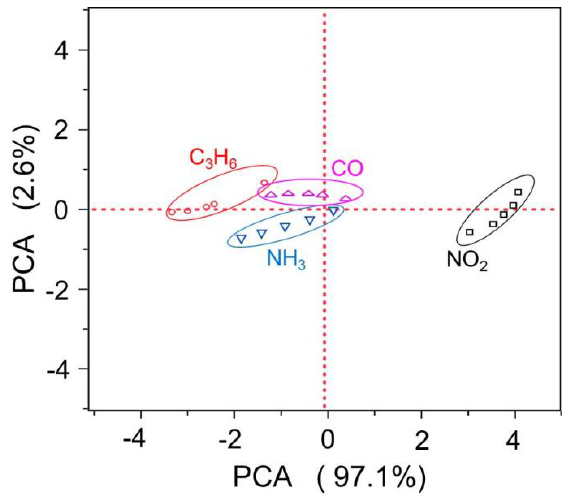
Figure 7. PCA schemes of the data set for the sensor utilizing (In 2 O 3 + 15 wt.% ZnO)-SE, operated in the temperature modulation mode.